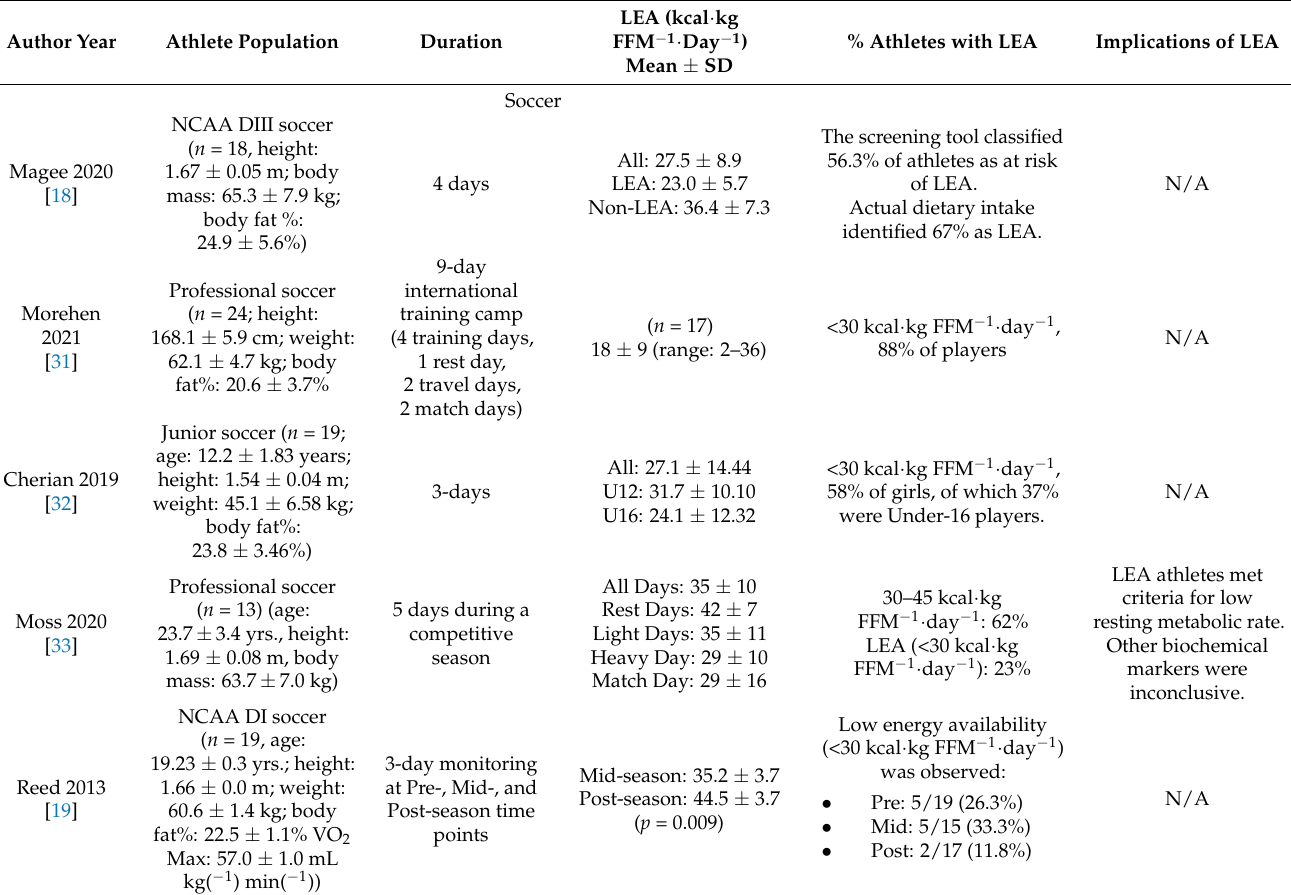
Table 1. Prevalence of low energy availability (LEA) in female